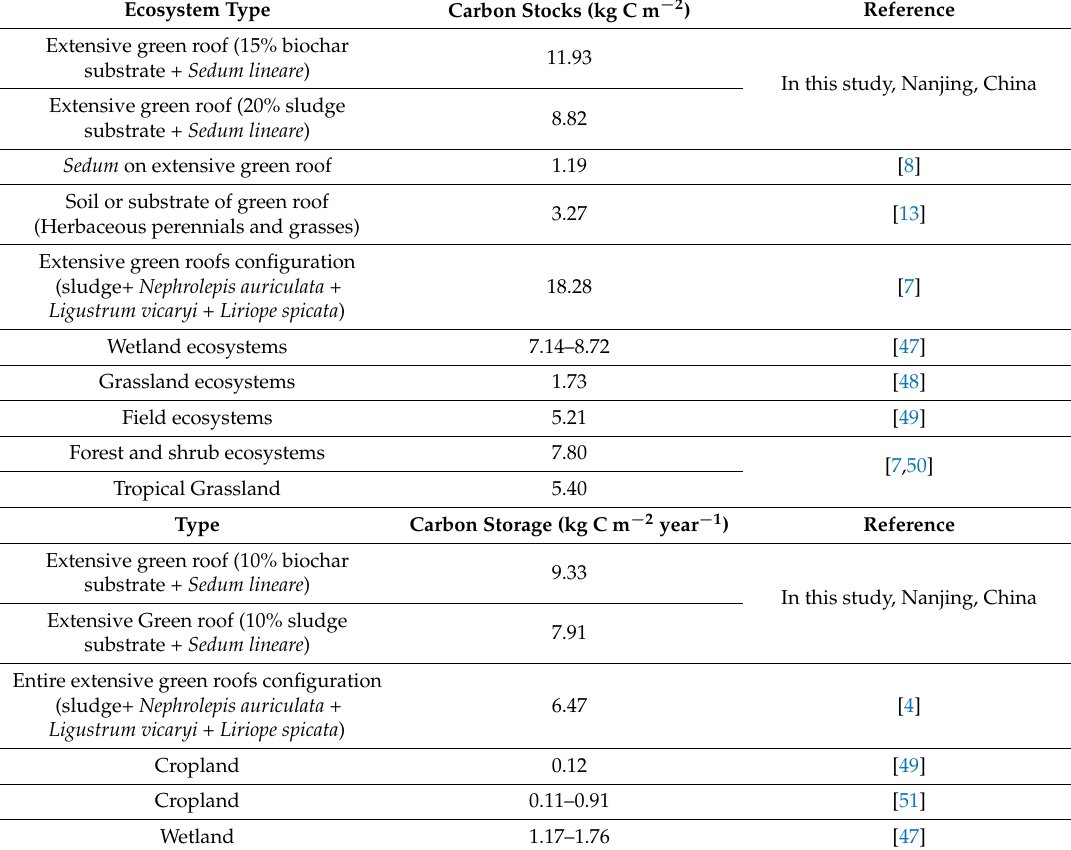
Table 3. Carbon stocks (kg C m − 2 ) and carbon storage (kg C m − 2 year − 1 ) of different green roofs and